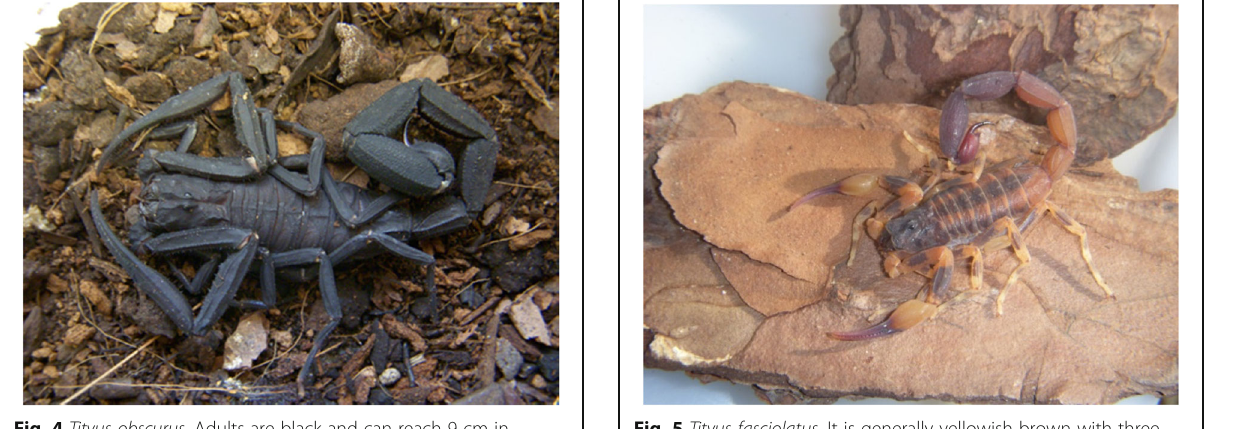
Fig. 4 Tityus obscurus . Adults are black and can reach 9 cm in length. However, young animals are brown. They present sexual reproduction. Source: Brazilian Ministry of Health [6]. Image